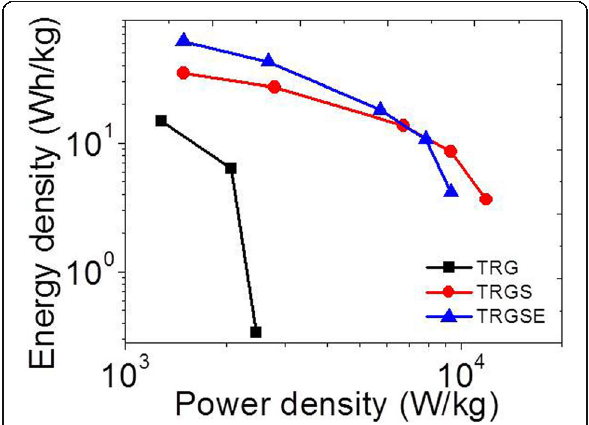
Fig. 10 The Ragone plot of the TRG, TRGS and TRGSE